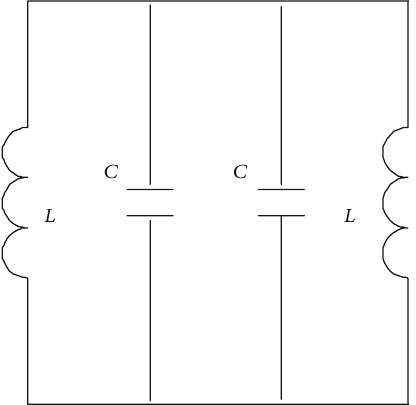
Figure 5: Equivalent model of FSLA